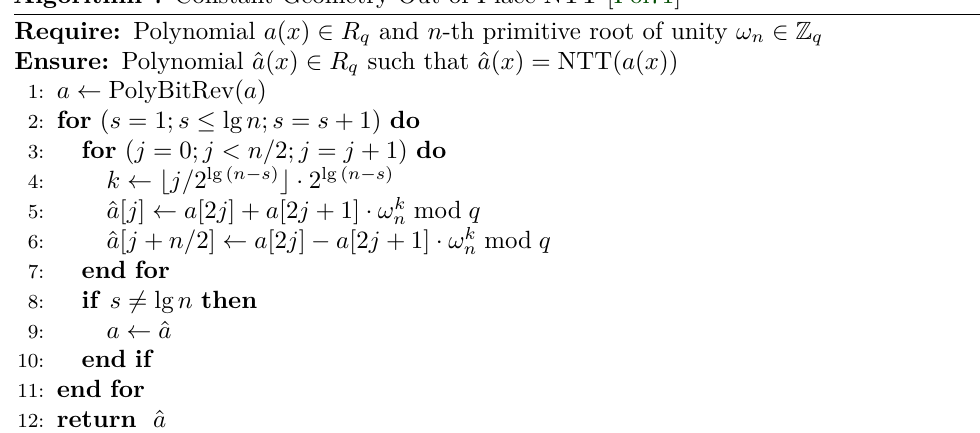
Algorithm 7 Constant Geometry Out-of-Place NTT